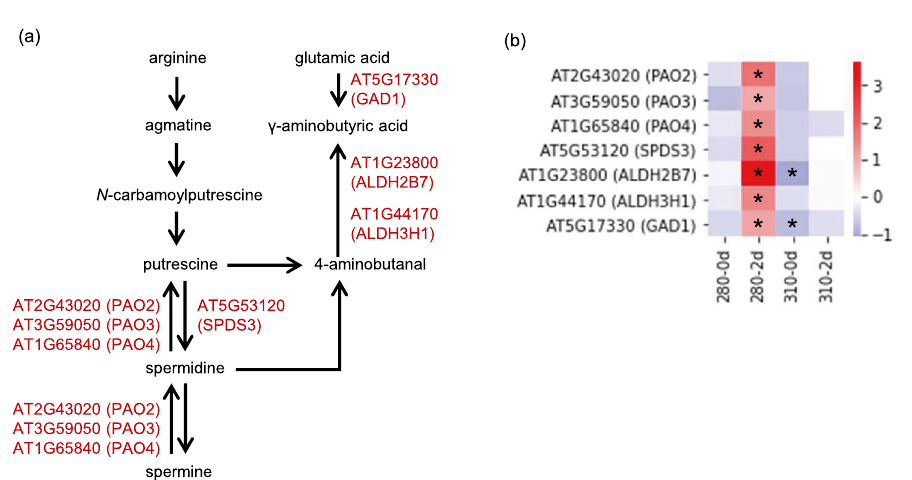
Figure 5. Gene expression profiles of enzymes in polyamine metabolism and GABA biosynthesis under 280 and 310 nm UV-LEDs. ( a ) Metabolic map of polyamine metabolism and GABA biosynthesis. ( b ) Heat map showing the expression level of enzymatic genes in polyamine metabolism and GABA biosynthesis. Changes in gene expression levels relative to the control are expressed as log 2 (fold change) values. As shown on the color scale, blue indicates down-regulation and red indicates up-regulation. Asterisks indicate significant differences between the control and UV-LED irradiation using Welch’s t -test ( P <